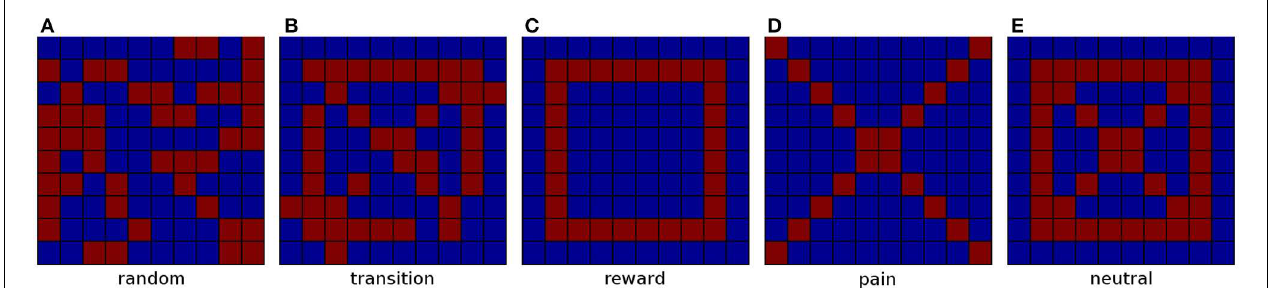
neutral (E) is not. Transitions progress toward the neutral composite icon pattern (E) , before completing as (E), or diverging to one of the pre-conditioned icons (C or D) .